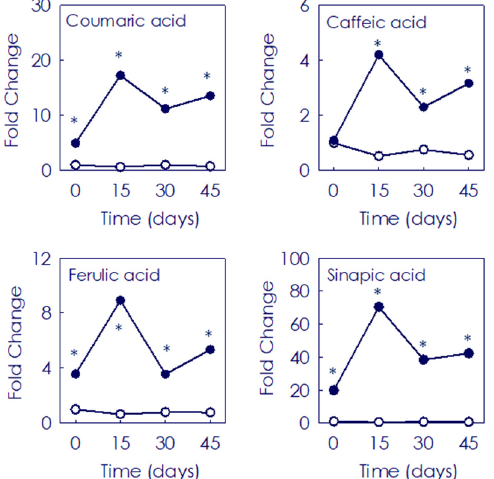
Figure 3. Fold change of the 4 main hydroxycinnamic acids identified in the pulp of Moro ( ● ) and Pera ( ○ ) oranges during storage for 0, 15, 30 and 45 days. Data are expressed as the mean fold change ± SD of each sample as compared to the control Pera fruits sample (at harvest time). Asterisk indicates statistically significant different values ( p ≤ 0.01) for each given time point when comparing cultivars.